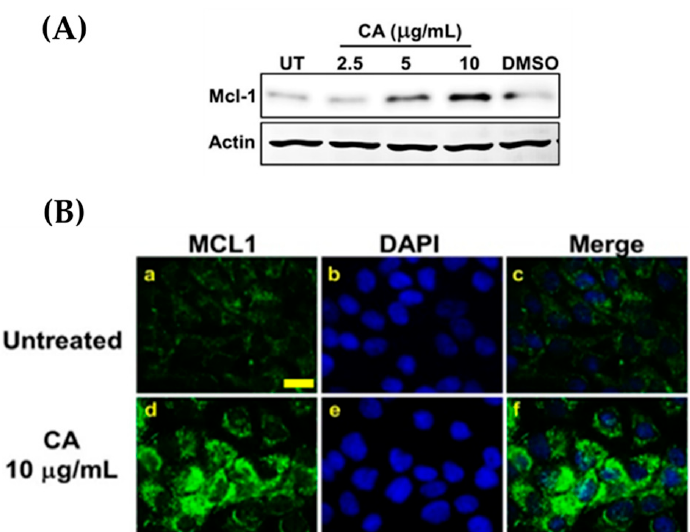
Figure 8. Effects of CA extract on Mcl-1 expression in HaCaT cells detected by Western blot analysis ( A ); and immunofluorescence study (100× magnification, scale bar = 200 µm) ( B ). Data were obtained from three individual experiments.